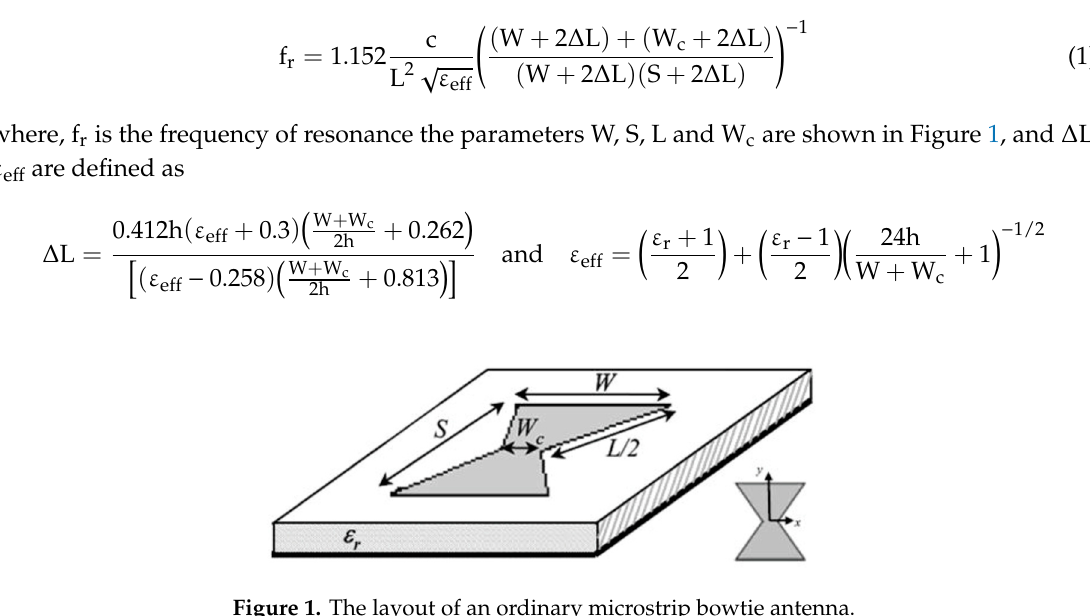
Figure 1. The layout of an ordinary microstrip bowtie antenna.